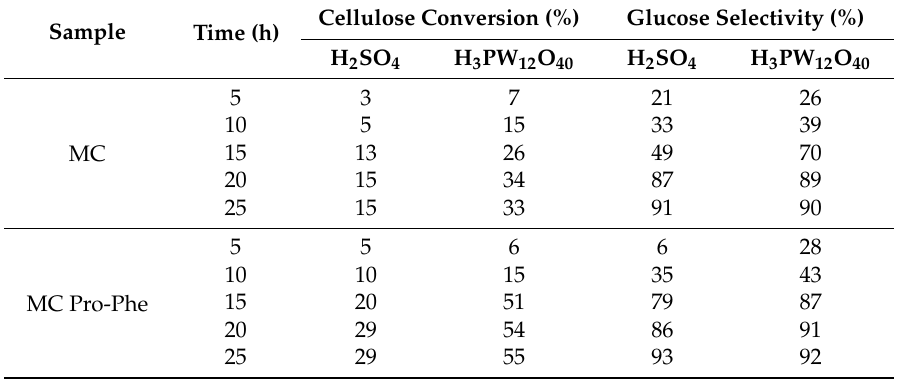
Table 3. Glucose selectivity in hydrolysis reaction of cellulose using two